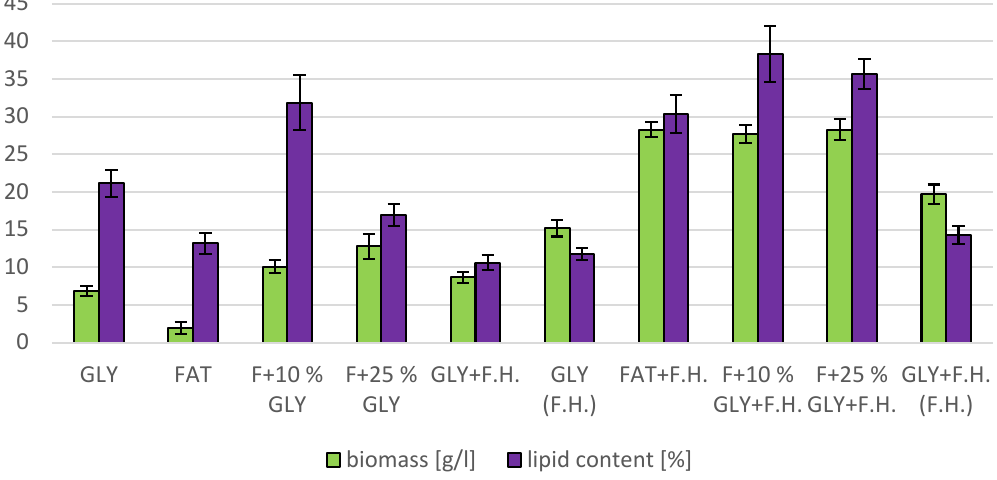
Figure 14. Biomass and lipid production by biomass of yeast strain Rhodotorula mucilaginosa (CCY 19-4-25) in conditions of C/N ratio 50